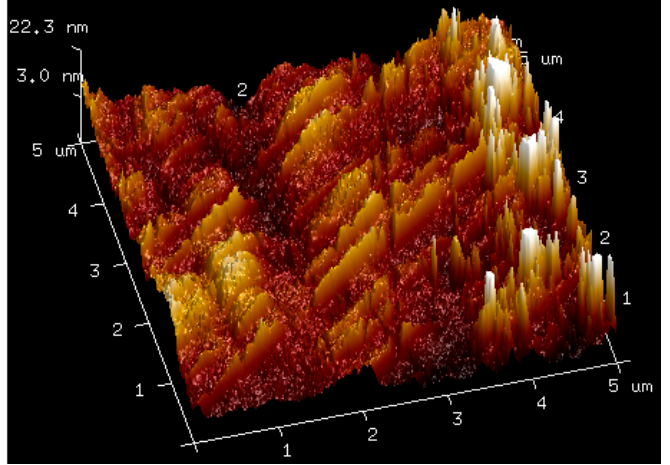
Figure 6. AFM visualization of the surface of film obtained from the solution of 1.5% ultralow-mo- lecular HA.